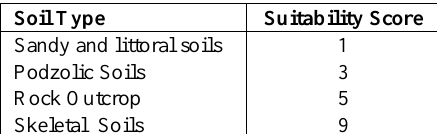
Table 4. Suitability Scores given for slope range